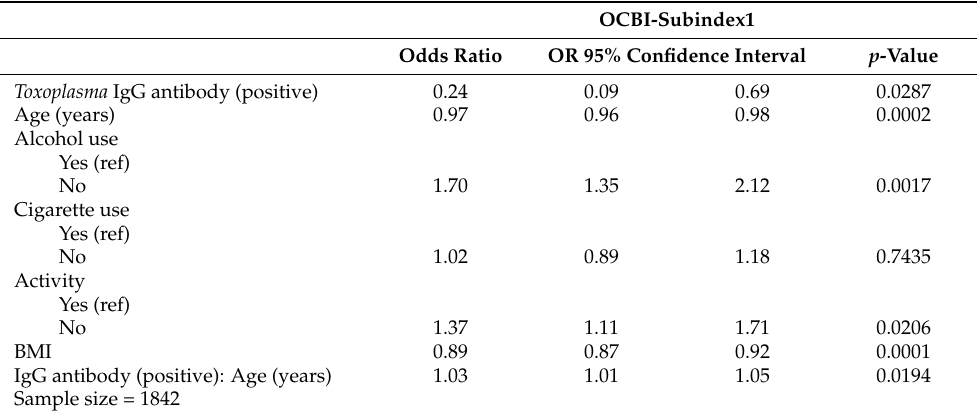
Table 10. Ordinal logistic regression model for the OCBI-Subindex1 on T. gondii IgG antibody (positive/negative) adjusted for the covariates.